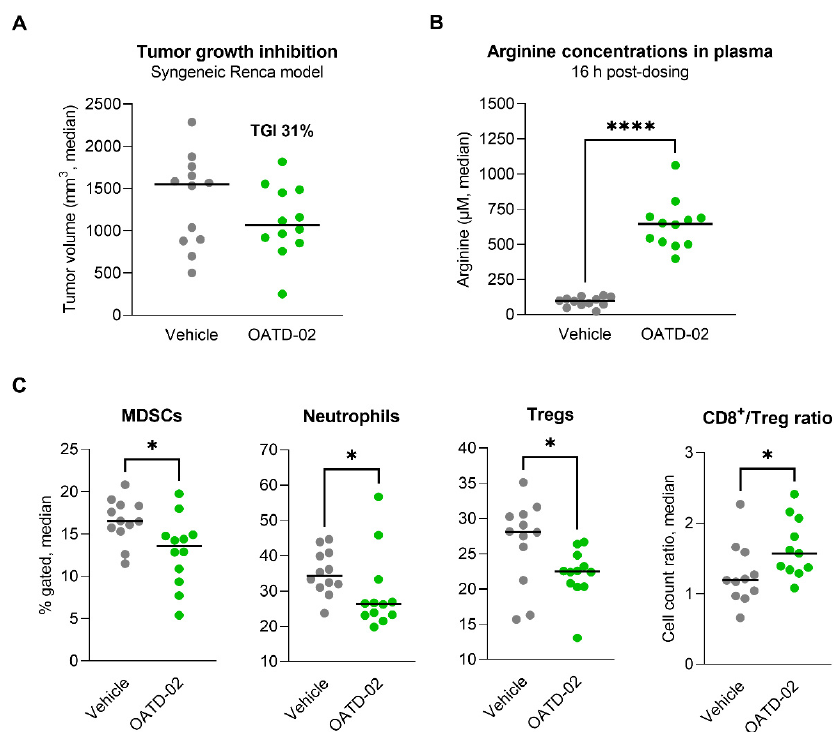
Figure 4. OATD-02 exhibits moderate efficacy in the cachexic Renca tumour model. ( A )—Renca tumour cells were inoculated at day 0 and OATD-02 was dosed at 75 mg/kg (PO, BID) from day 1 through the end of the experiment; final tumour measurements were taken at day 22 post-inoculation (TGI 31%, not statistically significant). ( B )—OATD-02 induced high increase in the L -arginine concentrations in plasma measured 16 h after the last dosing (**** p = 0.0001, U Mann–Whitney test). ( C )—Significant changes in the immune infiltration of the Renca tumours were observed upon OATD-02-treatment (* 0.0173 < p < 0.0284, U Mann–Whitney test); cell populations were identified by flow cytometry (MDSCs: Gr1 +/ − F4/80 +/ − within CD11b + cells, neutrophils: Gr1 ++ F4/80 − within CD11b + cells, Tregs: Foxp3 + within CD4 + T cells, CD8 + T cells: CD3 + CD4 − CD8 + cells).